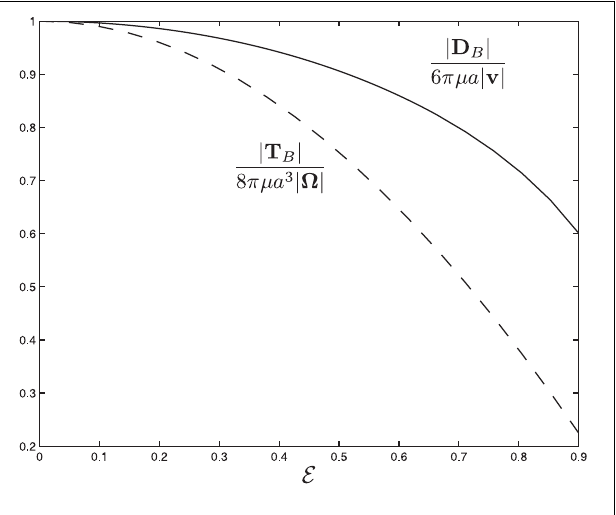
FIGURE 3 | The scaled drag force and the scaled viscous torque as a function of eccentricity E for α = 45 ◦ and γ = 45 ◦ .